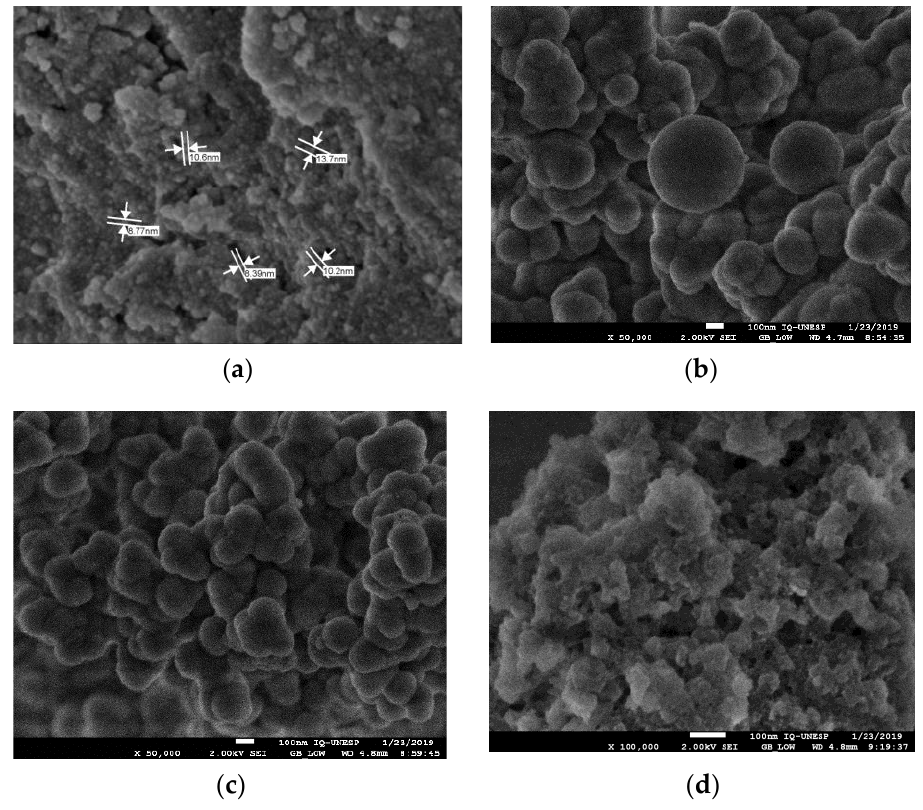
Figure 5. SEM Images of the synthesized nanomaterials: ( a ) Fe 3 O 4 — NPS; ( b ) Fe 3 O 4 @SiO 2 ; ( c ) Fe 3 O 4 @MPS; ( d ) SP-MIP